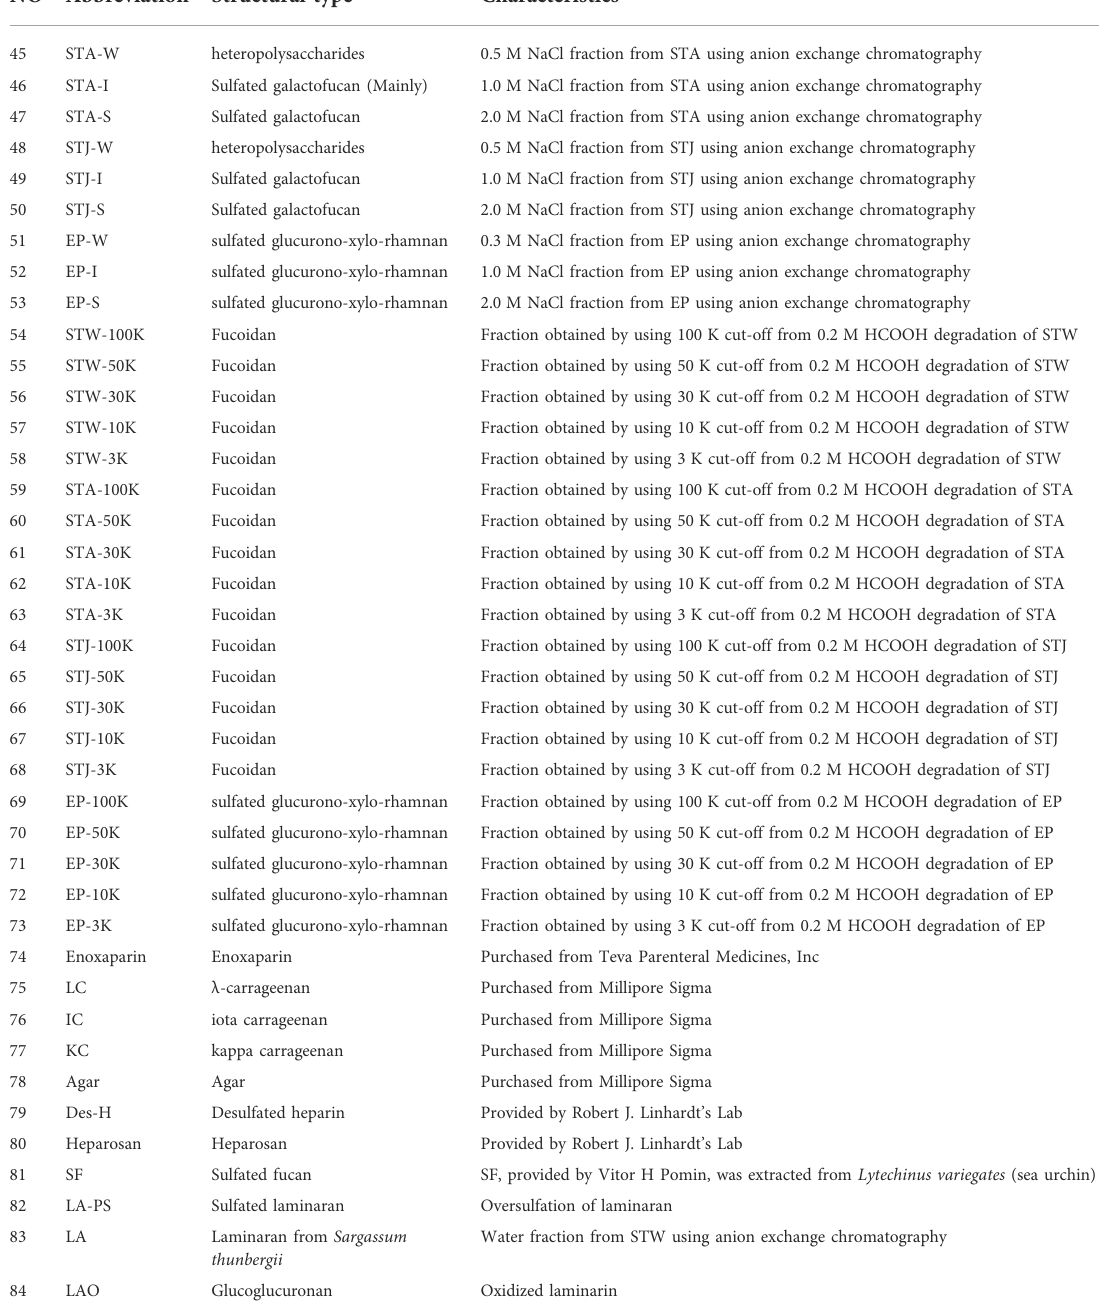
anticoagulant and heparin induced thrombocytopenia (HIT). In current study, SPR was applied to measure the binding kinetics and af fi nity of AT and PF4 interaction with heparin using a sensor chip with immobilized heparin. Sensorgrams of AT and PF4 interactions with heparin are shown in Figure 2. Binding kinetics (i.e., association rate constant: ka